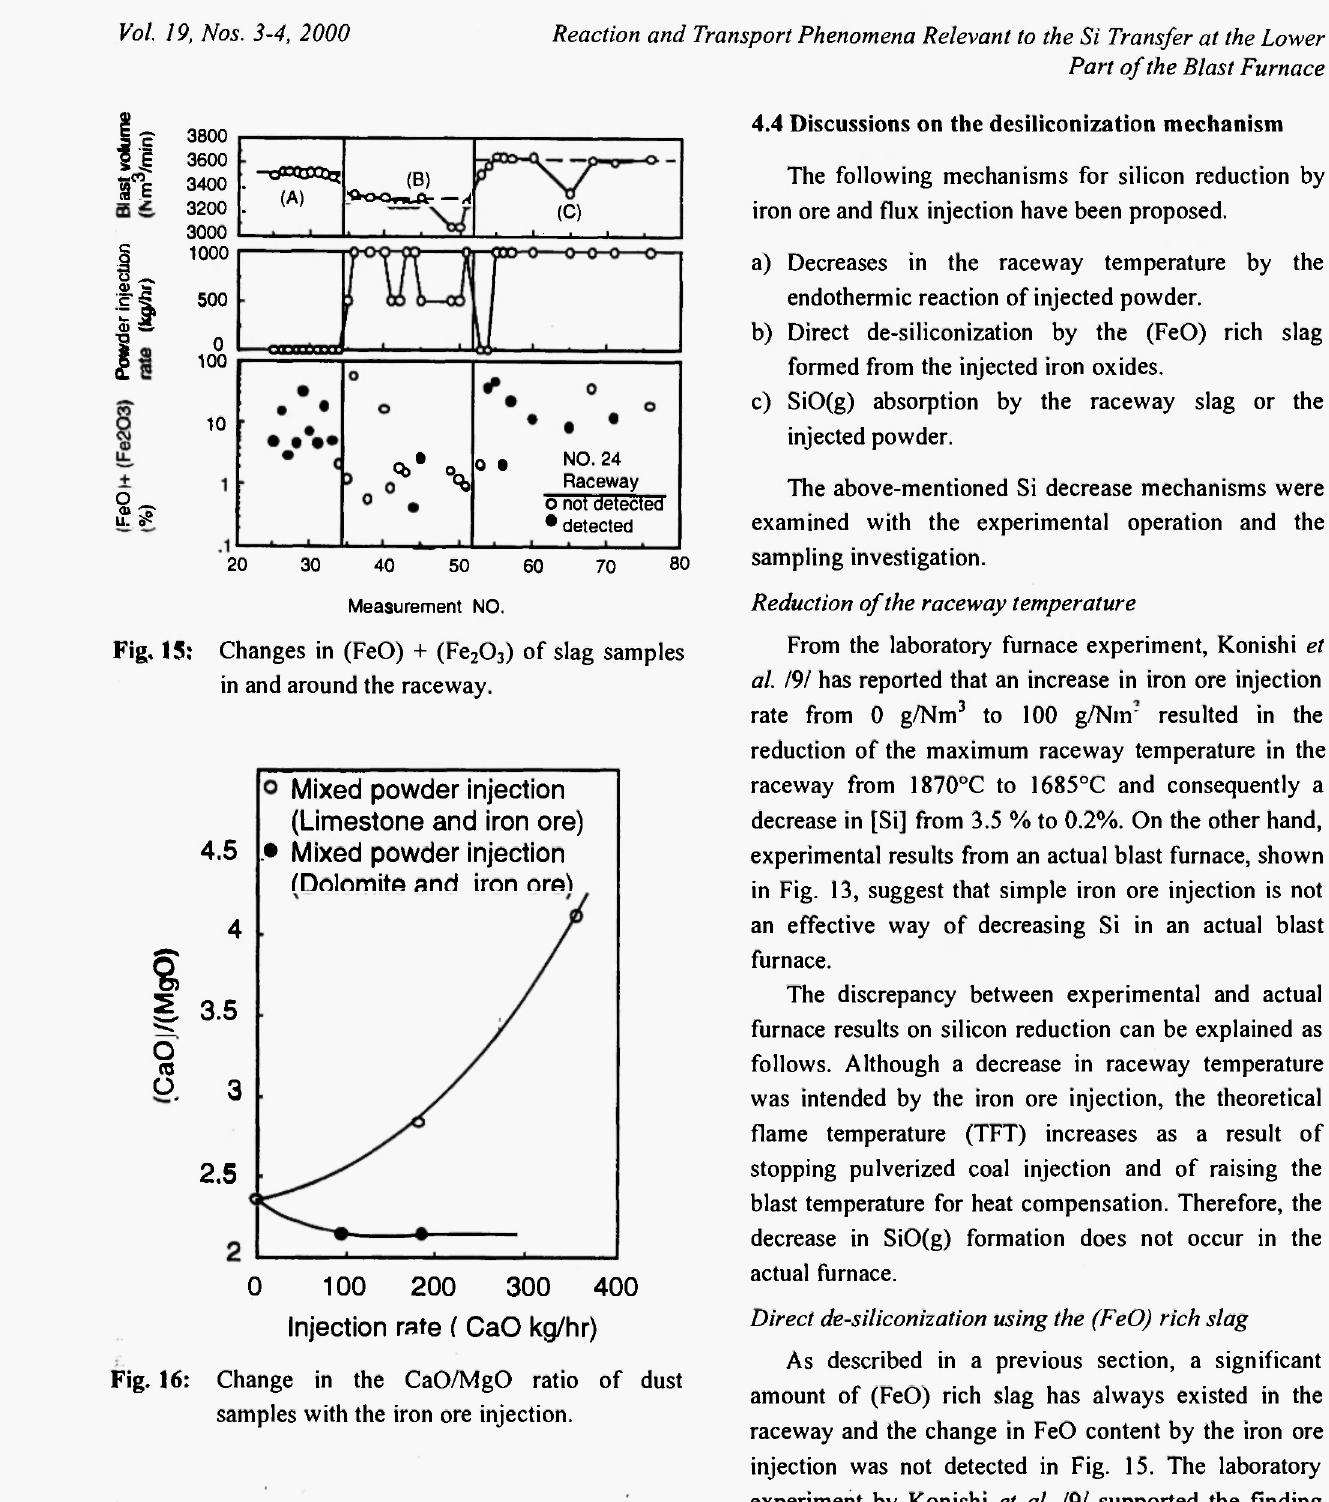
positions were almost the same in all periods as shown in Fig. 1, the (FeO) rich slag may have been taken inside the raceway, where the FeO rich slag has always existed as discussed in a previous